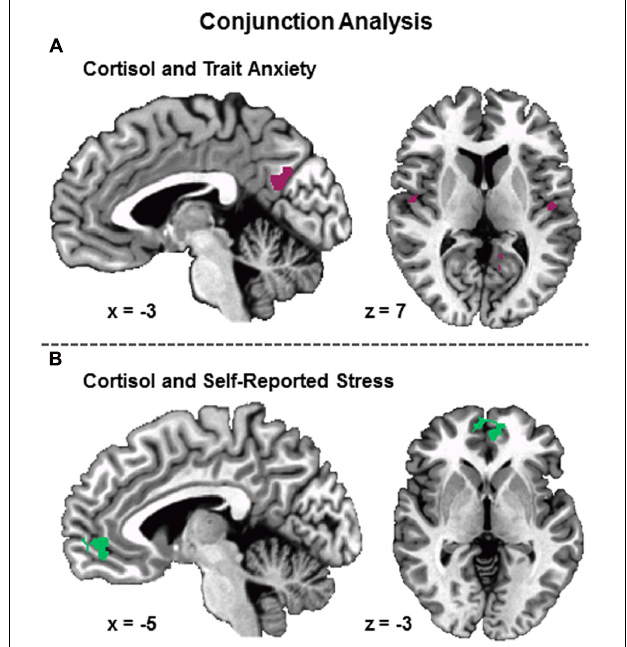
differential (Stress vs. Control) BOLD fMRI signal during the MIST. Conjunction of cortisol and trait anxiety showed overlapping areas of activation within posterior cingulate cortex and bilateral superior temporal gyrus (A) . Conjunction of self-reported stress and cortisol showed overlapping areas of activation within ventromedial prefrontal cortex (B) . No overlapping areas were identified between trait anxiety and self-reported stress or the conjunction of trait anxiety, self-reported stress, and cortisol. Results FWE corrected at p <